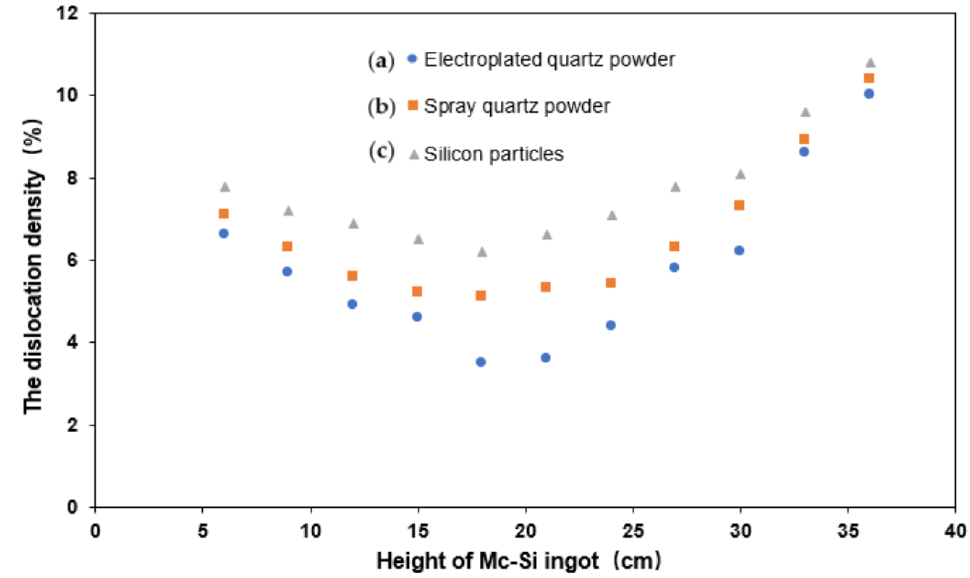
7 of 9 Figure 6. Defect images of Mc-Si bottom wafers assisted by ( a ) electrophoretic deposited quartz powder, ( b ) spray quartz powder, and ( c ) silicon particles. In order to more accurately understand the dislocation density distribution of the Mc-Si ingot with different nucleation materials assisted growth at different positions. Every 3 cm, we took a piece 6 cm from the bottom of the crucible and calculated the dis- location density at different positions through polishing and dislocation corrosion treat-